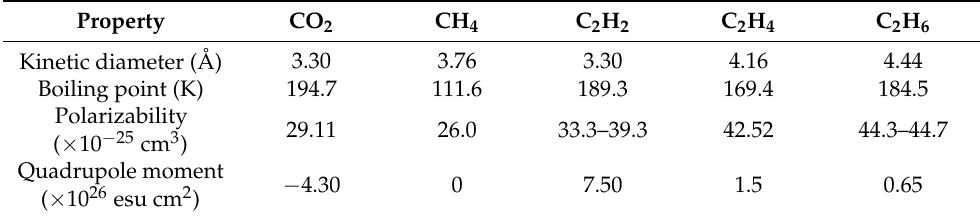
Table 1. Main physicochemical properties of CO 2 and common light hydrocarbons [24,25]. Property CO 2 CH